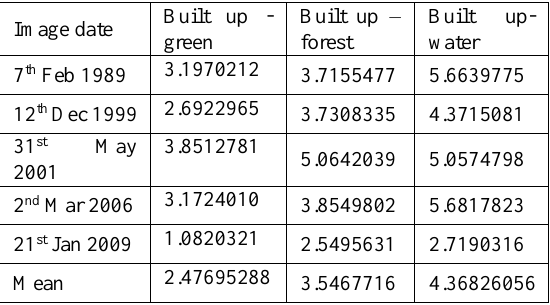
Table 3. The post hoc test for the available images Generally, 21 st Jan 2009 images has the lowest difference among the land cover types, while 7 th Feb 1989 showed the highest difference compared to other images. The difference of urban and other land cover types was calculated; which indicated that built up and water (4.4° Celsius) had the highest difference of mean temperature compared to the other land cover types, whereas built up and green showed the lowest temperature difference (2.5° Celsius).